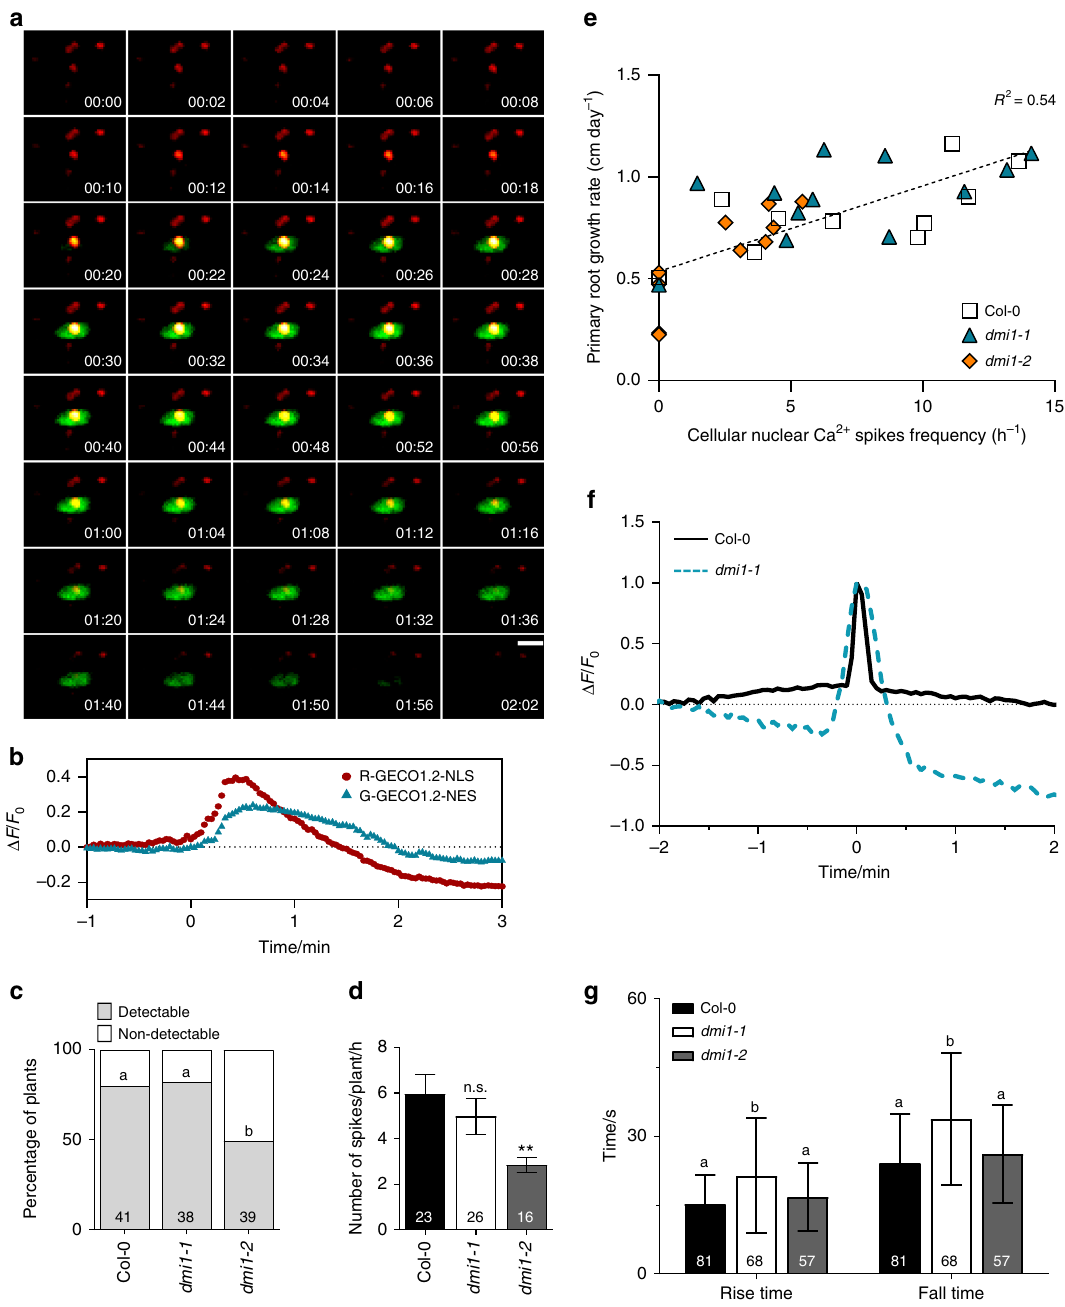
Fig. 2 Nuclear Ca 2 + signals occur during root growth and are dependent on DMI1 in Arabidopsis thaliana . a Representative growth-induced Ca 2 + signal in a cell in the root tip of a 5-day-old wild-type seedling expressing the dual sensor R-GECO1.2-NLS/G-GECO1.2-NES. Timestamps are min:s. Scale bar represents 10 μ m. b Normalised fl uorescence intensity over time measured in the R-GECO1.2 (red) and G-GECO1.2 (blue) channels. c Percentage of plants that displayed cell autonomous nuclear Ca 2 + spikes during root growth in Col-0, dmi1-1 , and dmi1-2 over 1 h and half of imaging. Numbers in bars represent the total of plants imaged ( n ) ( Χ 2 test, different letters represent p < 0.05). d Number of Ca 2 + spikes per plants per hour in Col-0, dmi1-1 , and dmi1-2 within 200 μ m of meristem length. No multiple spikes per cell were observed. Values are means± s.e.m. Numbers in bars represent the total of plants imaged ( n ). n.s. not signi fi cant, ** p < 0.01 (one-way ANOVA with Dunnet ’ s multiple comparison test vs. Col-0). e Measure of the primary root growth rate (cm) in function of cellular nuclear Ca 2 + spike frequency. The growth rate was monitored at days 3 and 5 after germination and the Ca 2 + signals monitored at day 6. The slope is calculated based on all points. f Representative nuclear Ca 2 + trace in Col-0 and dmi1-1 . Signals were aligned by their maxima. g Rise and fall times of the Ca 2 + recorded in Col-0, dmi1-1 , and dmi1-2 . Values are means± s.d. (one-way ANOVA with Bonferroni ’ s multiple comparison test, different letters represent p < 0.001 for both rise and fall times)